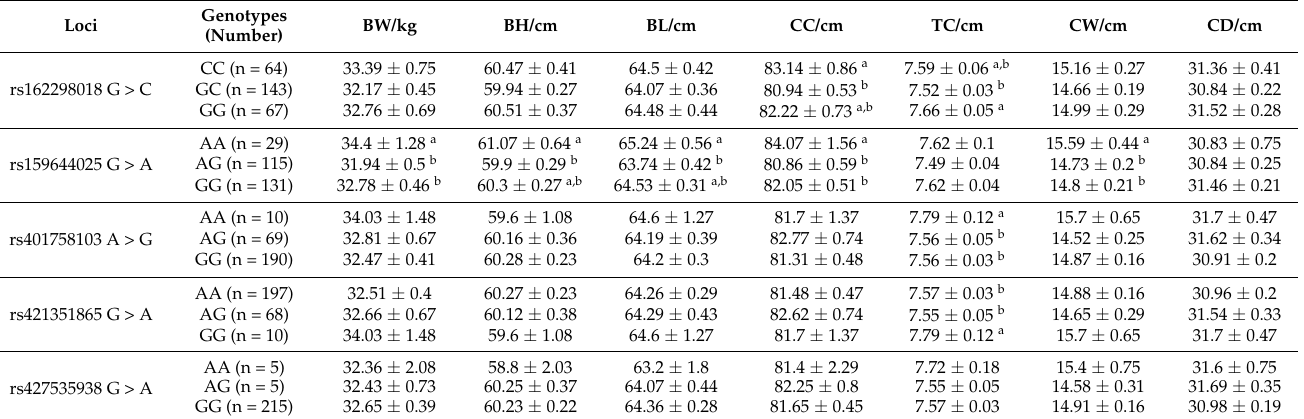
Table 7. Association analysis between the ARNT gene polymorphisms and growth traits of 6-month- old Ujimiqin